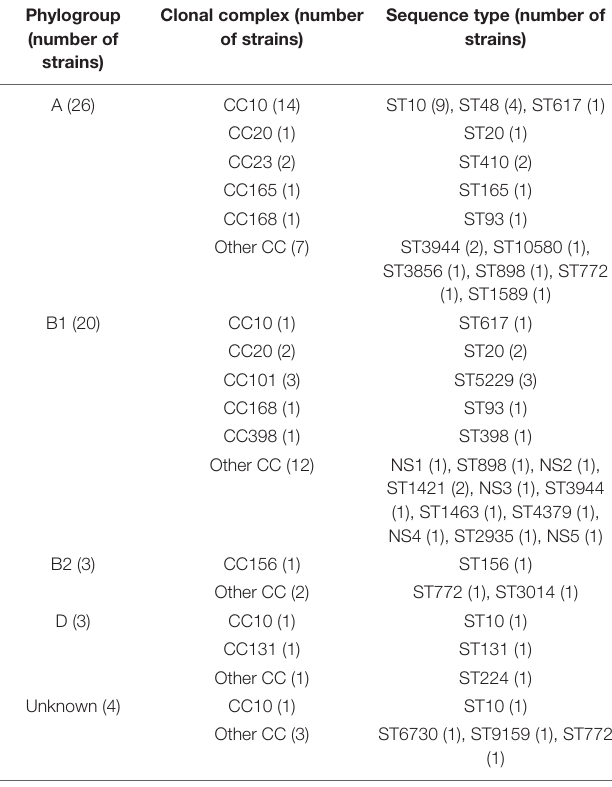
Sequence type (number of